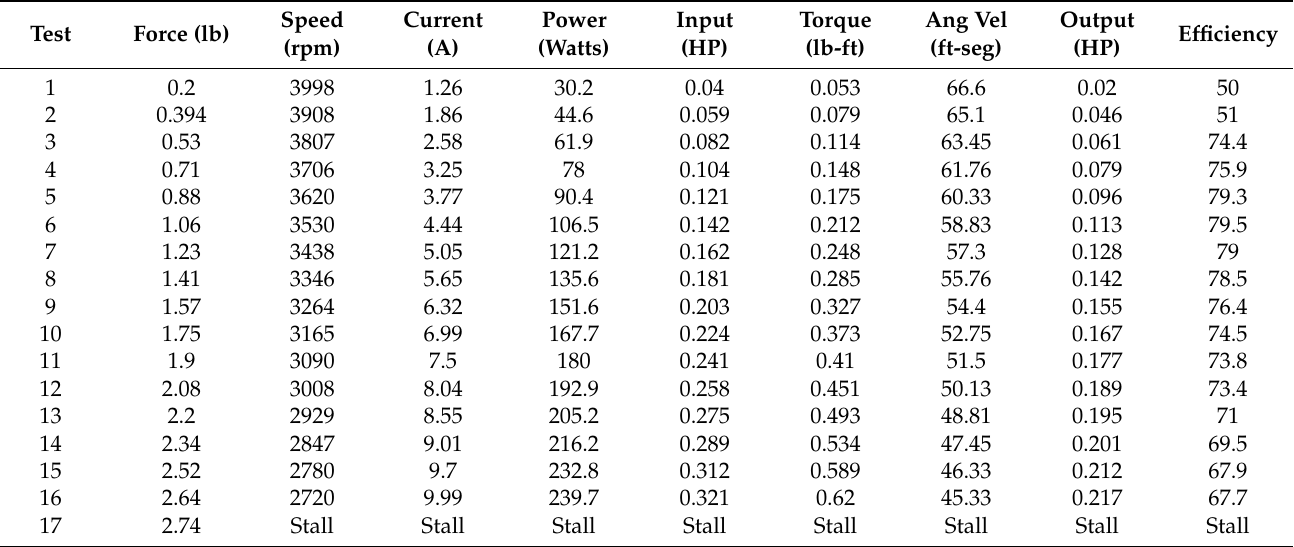
Table 5. Results of Motor